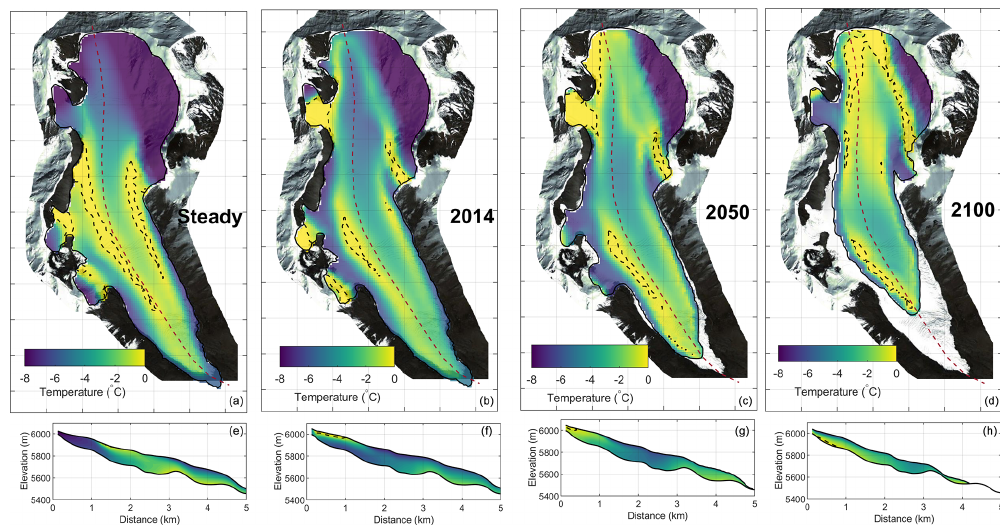
Figure 12. Same as Fig. 11 but without water percolation in